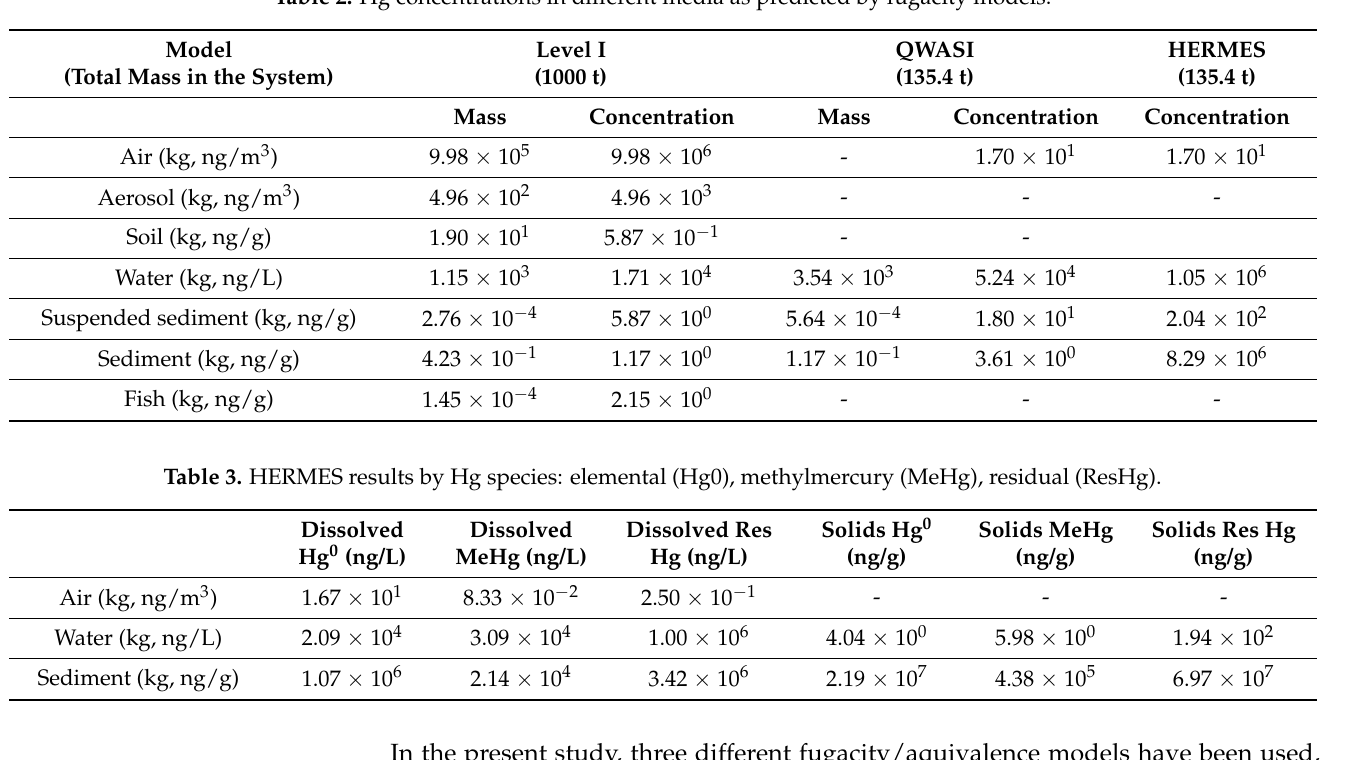
Table 2. Hg concentrations in different media as predicted by fugacity models.